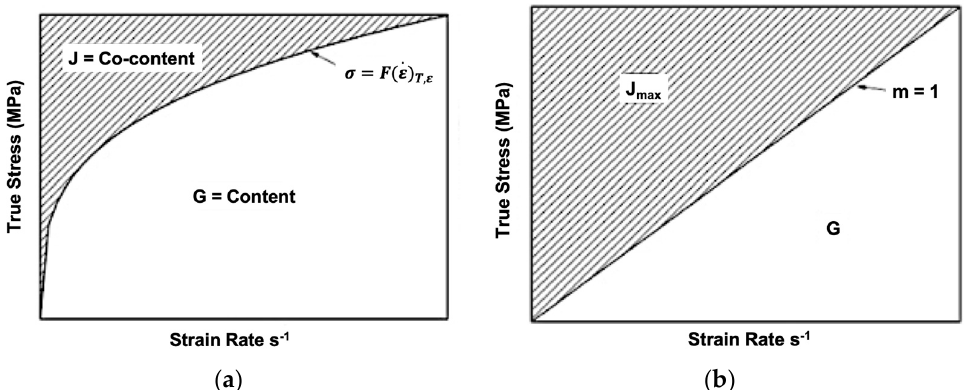
Figure A1. ( a ) Schematic representation of the constitutive equation in a non-linear dissipator ( b ) Ideal linear dissipator [5].